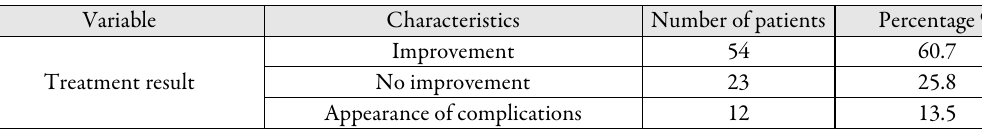
Figure 6. Percentage of preparation methods of plants Table 2. Treatment result